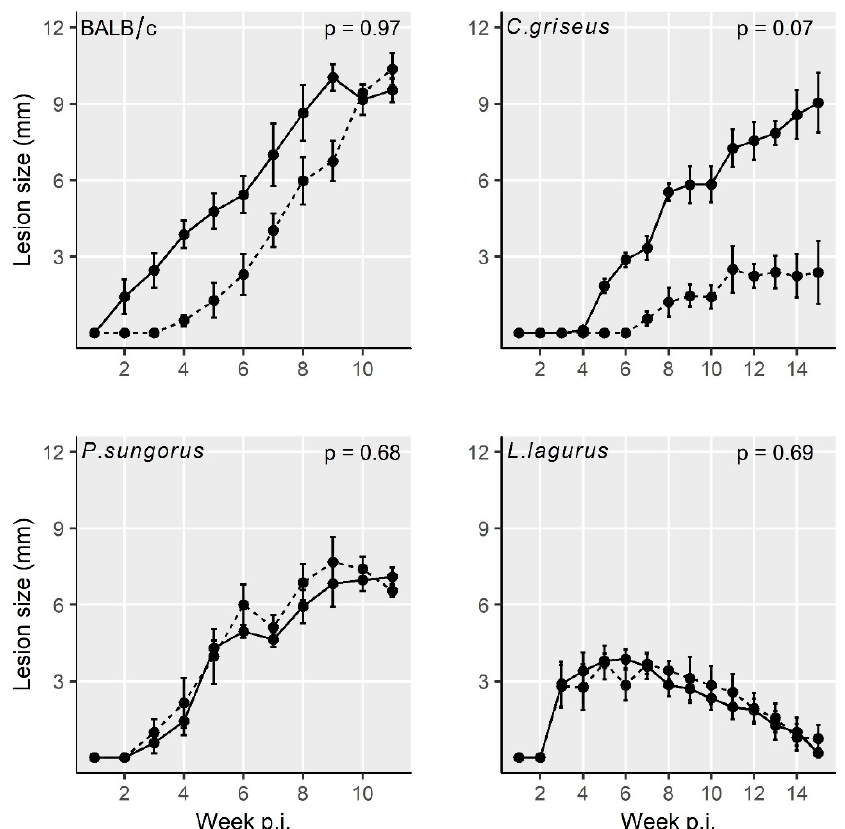
Figure 1. Lesion growth in animals inoculated with L. major using the two infection modes. Solid line = infection with culture-derived promastigotes (CDP); dashed line = infection with sand fly-derived promastigotes (SDP). P values indicate the statistical difference between the two infection types. Data are presented as the means ± standard errors of the means; 15% of the variance was explained by individual variability.